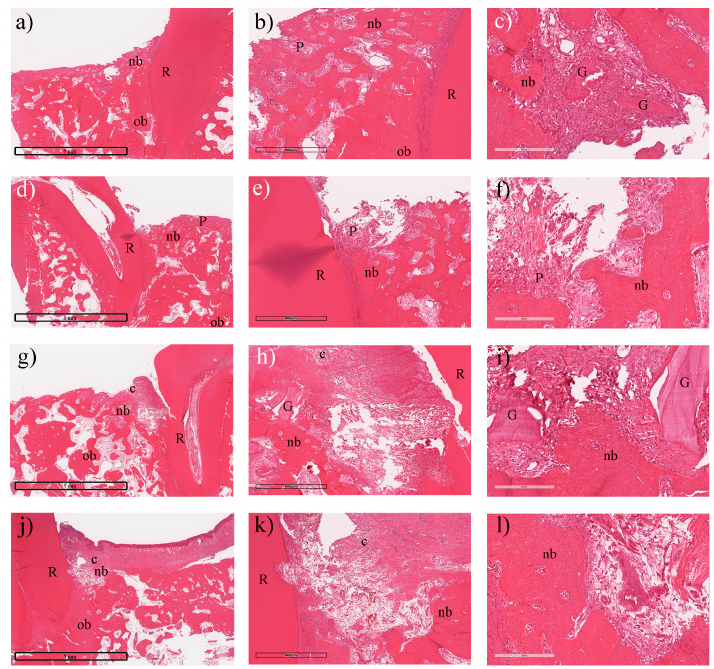
Figure 6. Histology and histomorphometric analysis (H&E stain): The use of both membranes showed similar behavior at 4 weeks post-surgery with residual collagen in the most coronal portion of the bone defect with woven new bone tissue and residual bone grafts filling the defect. Moreover, connective tissue surrounded some of the graft particles. ( a – c ) the test collagen membrane; ( d – f ) the control collagen membrane; In the test membrane group, ( a ) showed the intact test membrane (10×); ( b ) indicated new bone formation (nb) (80×) and ( c ) demonstrated residual bone grafts (G) (200×); In the control group, ( d ) showed the perforated membrane(10×); ( e ) performed new bone formation (nb), and ( f ) showed inflammation (P) without bone graft residual. At 8 weeks, ( g ) presented the test membrane (c) (10×); ( h ) showed the new bone formation (nb) without inflammation (80×) in the test group and ( i ) performed bone graft residual (G) (200×) under the test membrane. In the control group, ( j ) indicated the residual membrane (c) (10×); ( k ) showed the new bone formation (ob) surrounded with connective tissue (80×) and ( l ) also performed the higher magnification of (k) (200×). group with the control collagen membrane. No significant statistical difference was found. Figure 7. Percentage (%) distribution of the bone tissue, connective tissue, and residual bone grafts at ( a ) 4 and ( b ) 8 weeks.